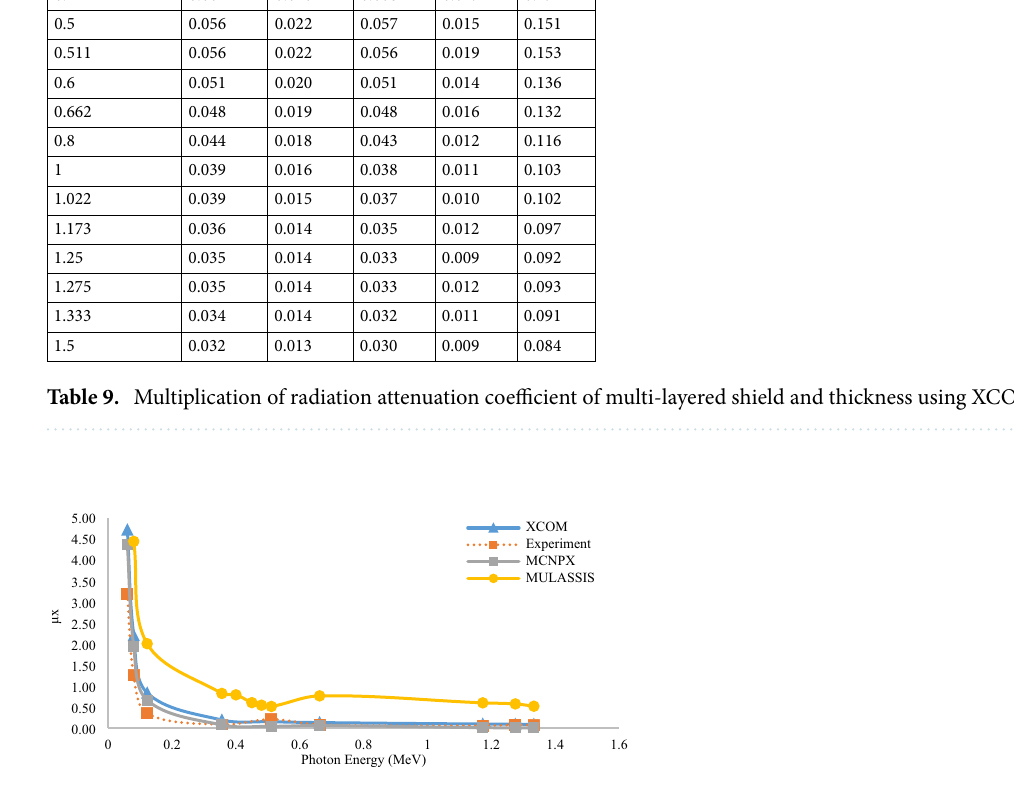
Figure 13. Comparison of radiation attenuation coefficient of multi-layer shield obtained from experimental, analytical and simulation